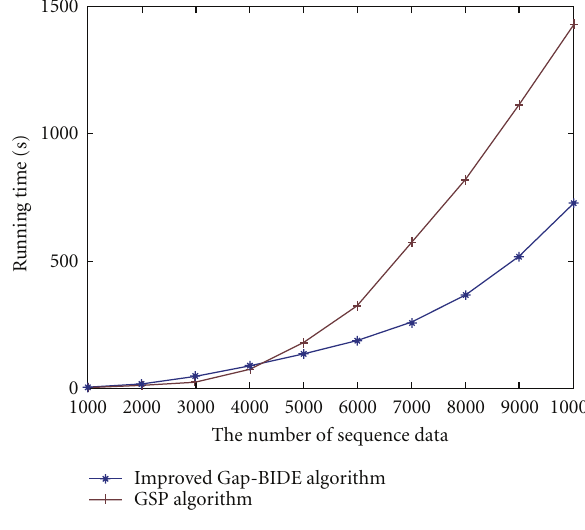
Figure 3: Comparing with GSP